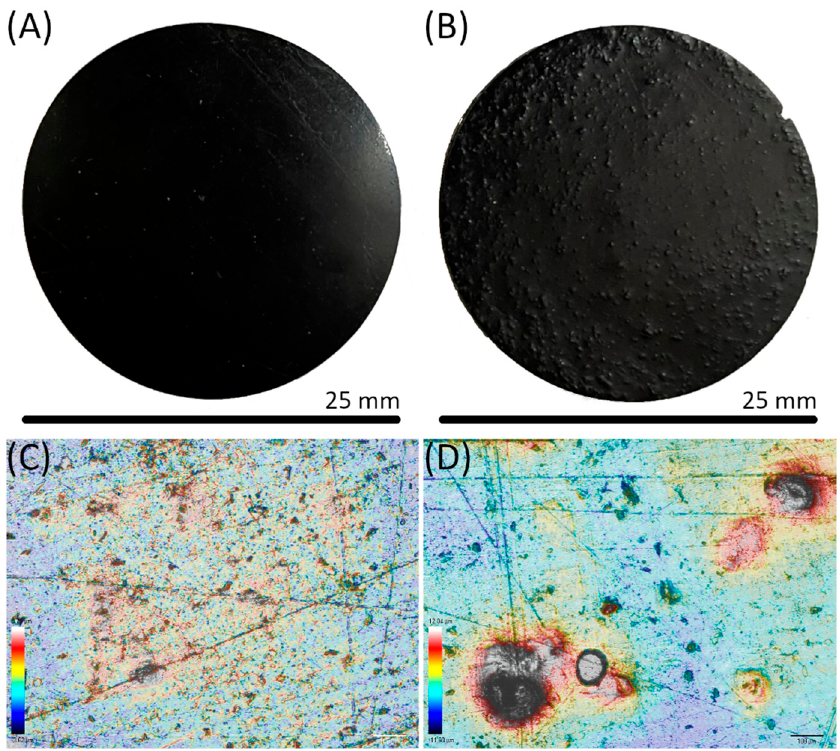
Table 4. R a (roughness average), R v (average max roughness valley depth), and R p (average max roughness peak height) of the pTSA-PANI acrylic composites.